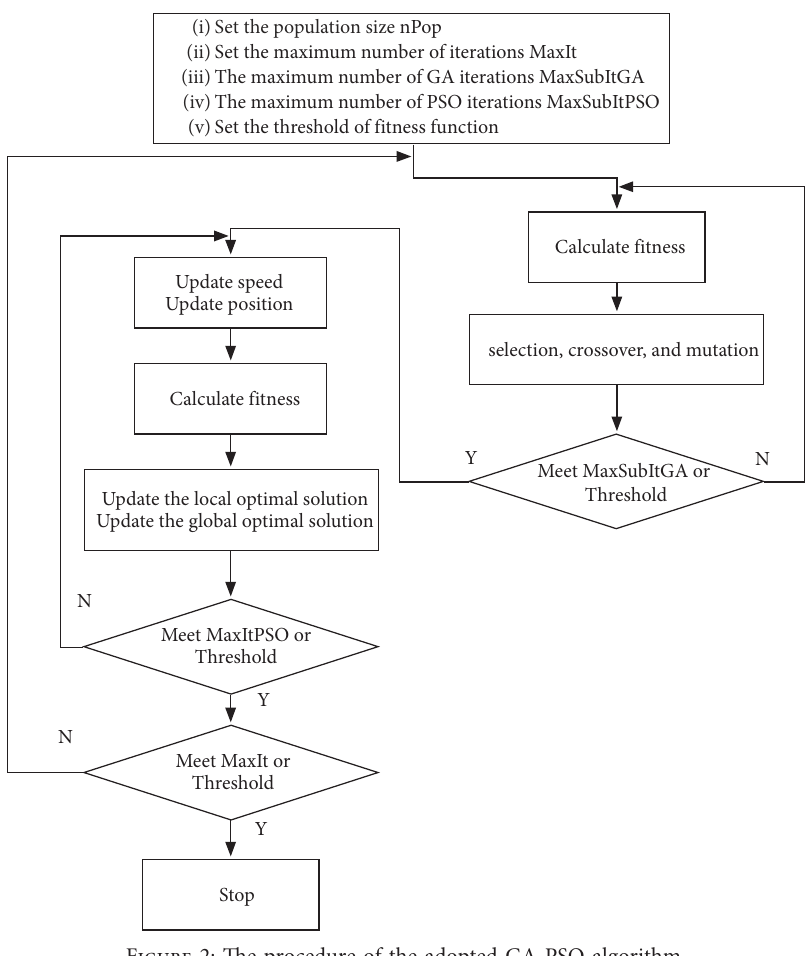
Figure 2: The procedure of the adopted GA-PSO